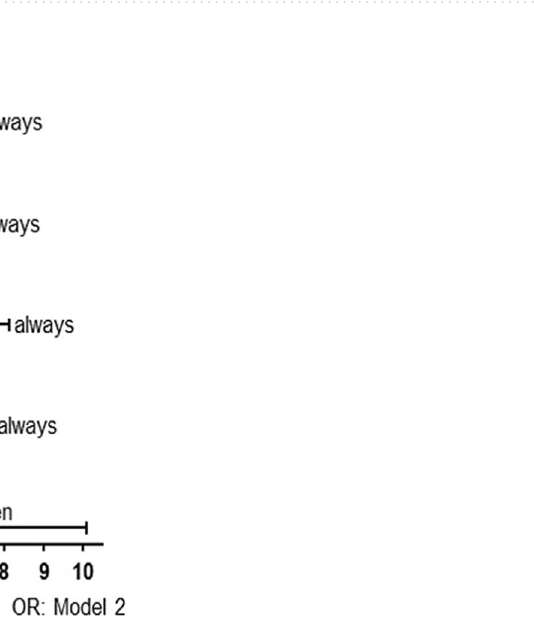
Figure 3. Frequency of feelings of social isolation and pain symptoms since before the COVID-19 outbreak. Odds ratios of each pain symptom in model 2 according to the frequency of feelings of social isolation compared to never felt feelings of social isolation were indicated. X-axis indicated odds ratio. Bars indicated 95% confidence intervals. Abbreviation: OR odds ratio.